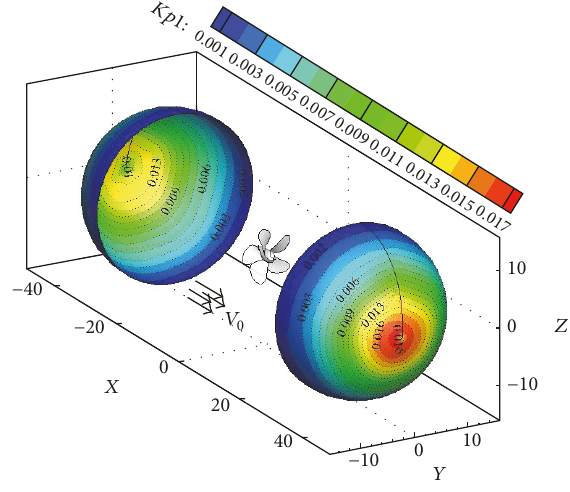
Figure 14: 3D contour of single propeller FPF.